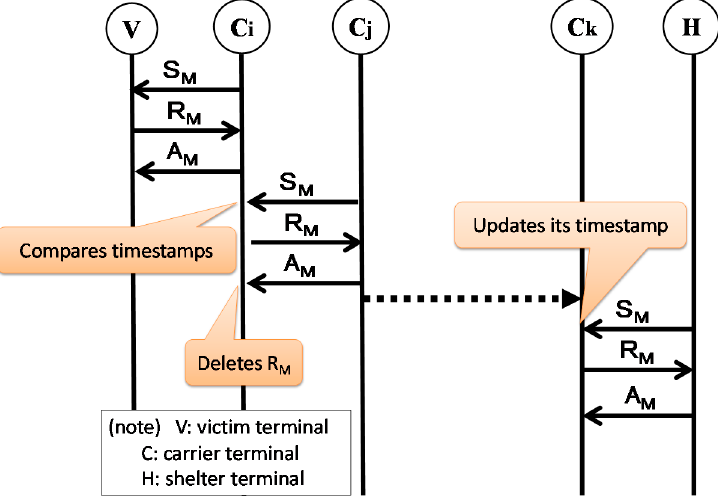
Figure 7. Sequence of communication from a victim terminal to a shelter